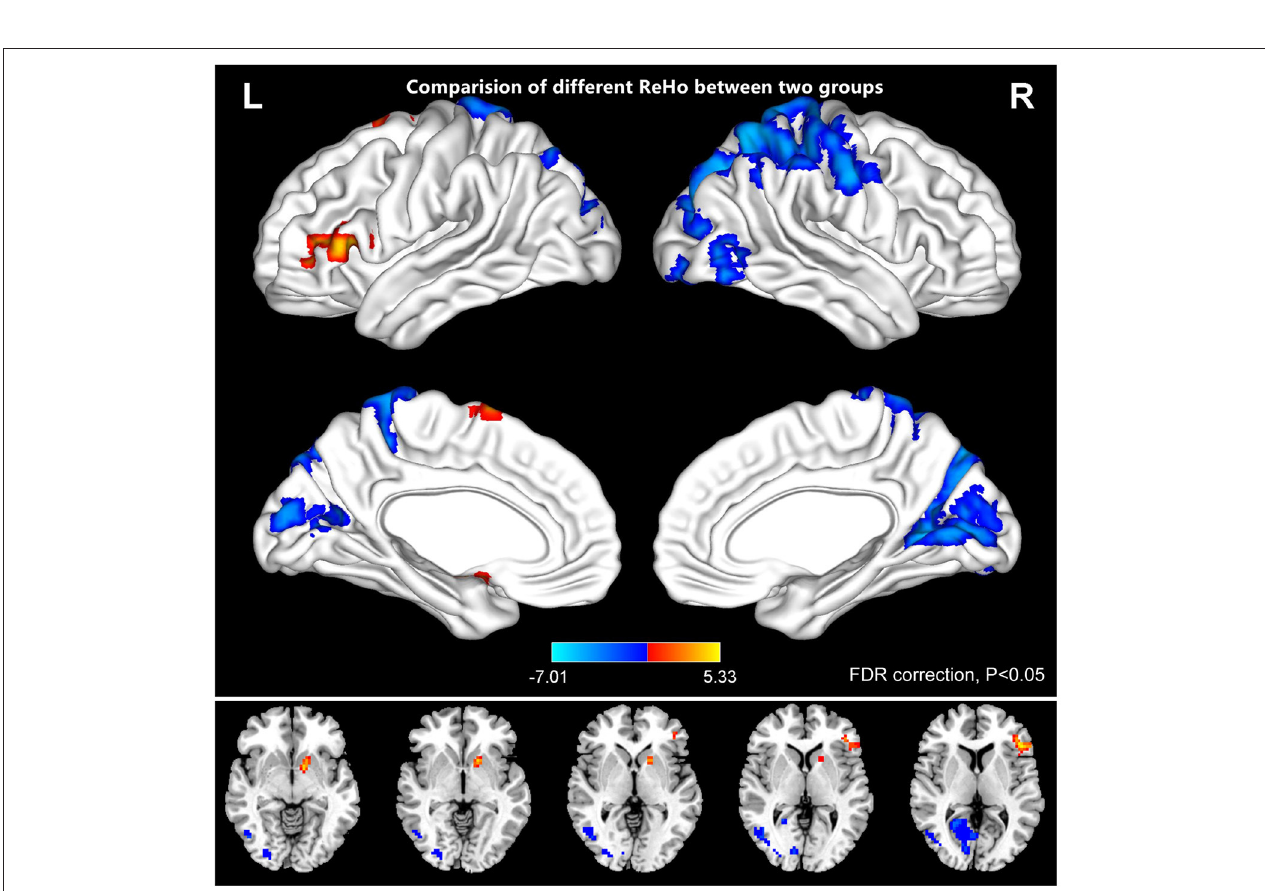
FIGURE 3 | The comparison of different ReHo between the patients of iridocyclitis and healthy volunteers. The iridocyclitis patients displayed significantly reduced ReHo values in the right inferior occipital gyrus, the right middle temporal gyrus, the bilateral calcarine, the right postcentral gyrus, the left superior occipital gyrus, and the left precuneus and displayed enhanced ReHo values in the right cerebellum, the left putamen, the left supplementary motor area, and the left inferior frontal gyrus compared with healthy volunteers (FDR correction, P < 0.05). Abbreviations: L, left; R, right; FDR, false discovery rate correction.